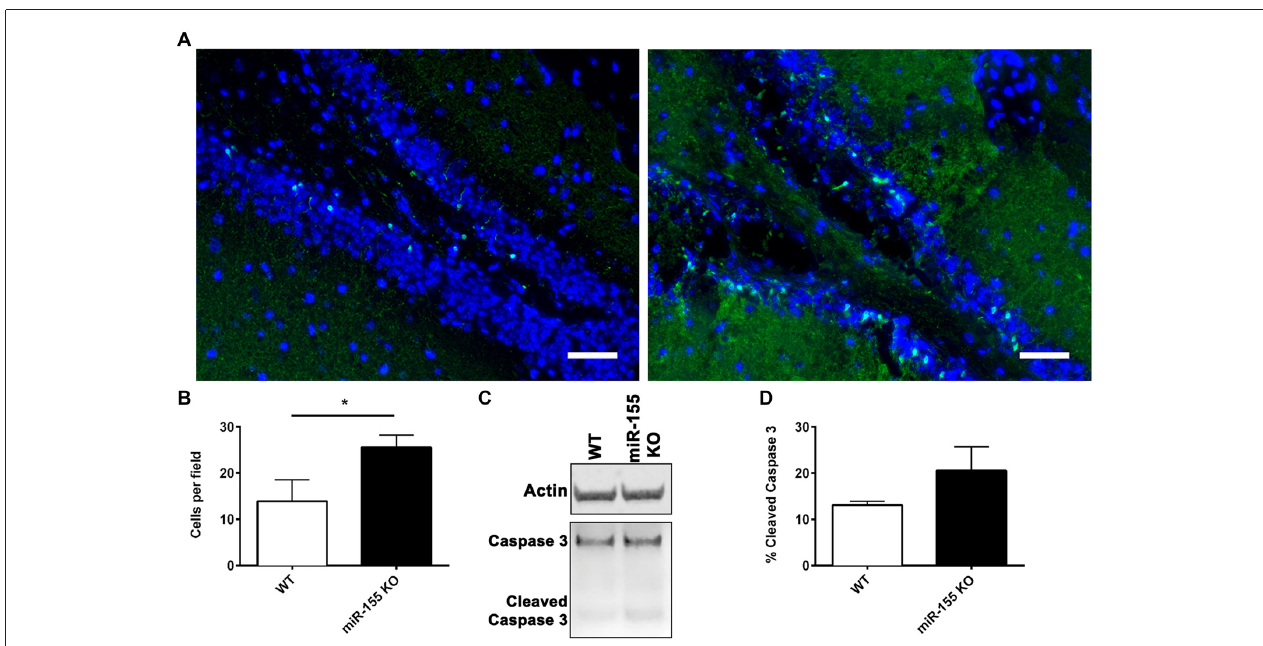
FIGURE 4 | Increased hippocampal neurodegeneration in miR-155 KO mice after CCI. Degenerating neurons were stained with fluoro-jade C (FJC; green) and DAPI (blue) 3 days after 1.0-mm CCI in the brains of WT ( n = 5) and miR-155 KO ( n = 6) mice. (A) Representative images from the ipsilateral DG. (B) Quantification of FJC positive cells in the DG. The mean ± SEM is shown. ∗ P < 0.05 by Student’s T -test. (C) Representative images of full-length and cleaved caspase 3 and beta-actin (Actin) analyzed by Western blot in WT and miR-155 KO ipsilateral hippocampi 3 days after 1.0-mm CCI. (D) Quantification of the percentage of cleaved Caspase 3 relative to full-length Caspase 3. The mean ± SEM are shown, ( n =